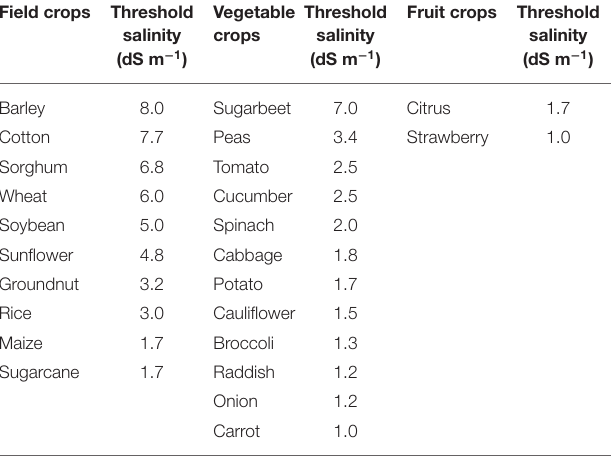
TABLE 6 | Relative tolerance of some crops to salinity (EC).